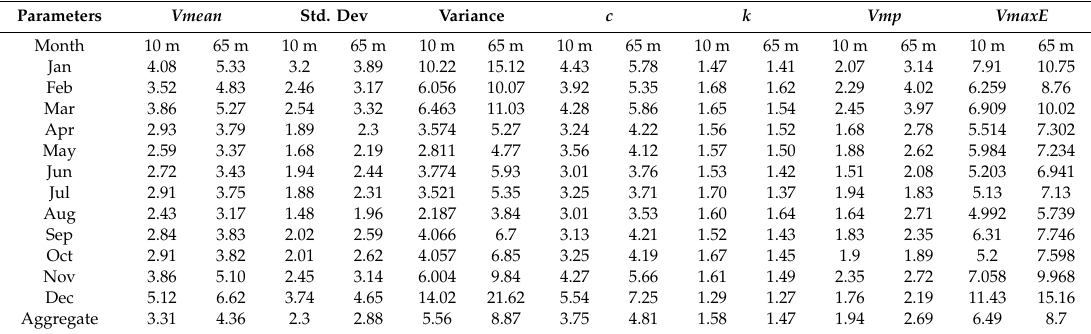
Table 2. Weibull parameters ( k and c ), monthly mean wind speed, Vmp , VmaxE , standard deviation and